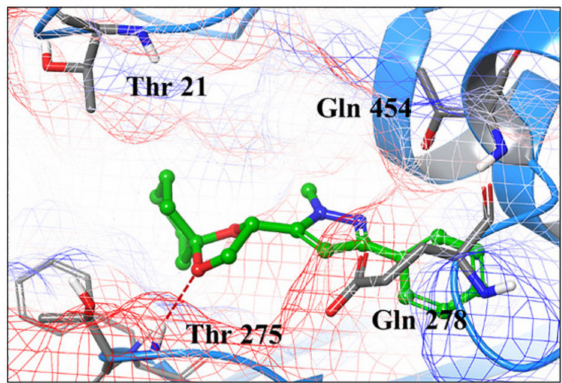
Figure 59. Structure of compound 53 , a pyrazole-based Lsrk inhibitor.